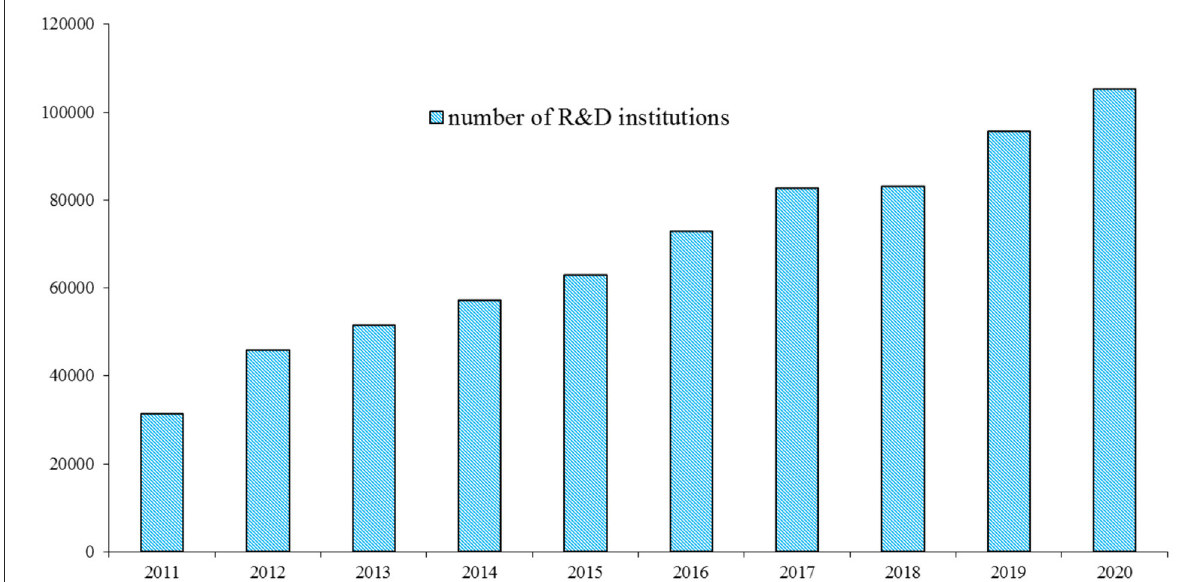
FIGURE5 Number of research and development (RandD) institutions located in the industrial sector in China during 2011–2020 (unit). Source: The author obtained the information from the China Statistical Yearbook on Science and Technology